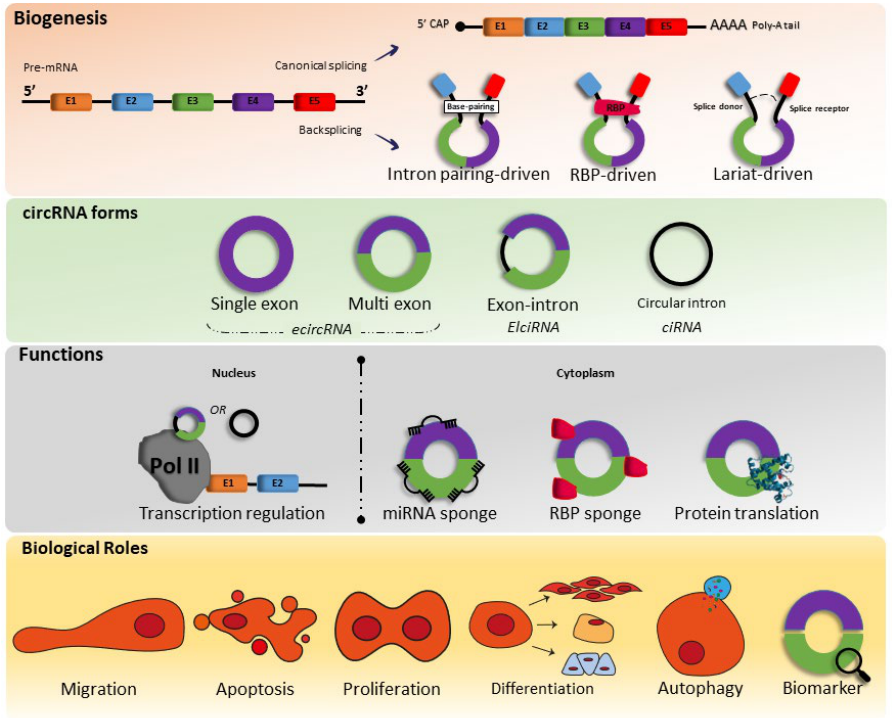
Figure 1. Biogenesis, forms, functions, and biological roles of circRNAs. miRNA—microRNAs; RBP—RNA-binding proteins.